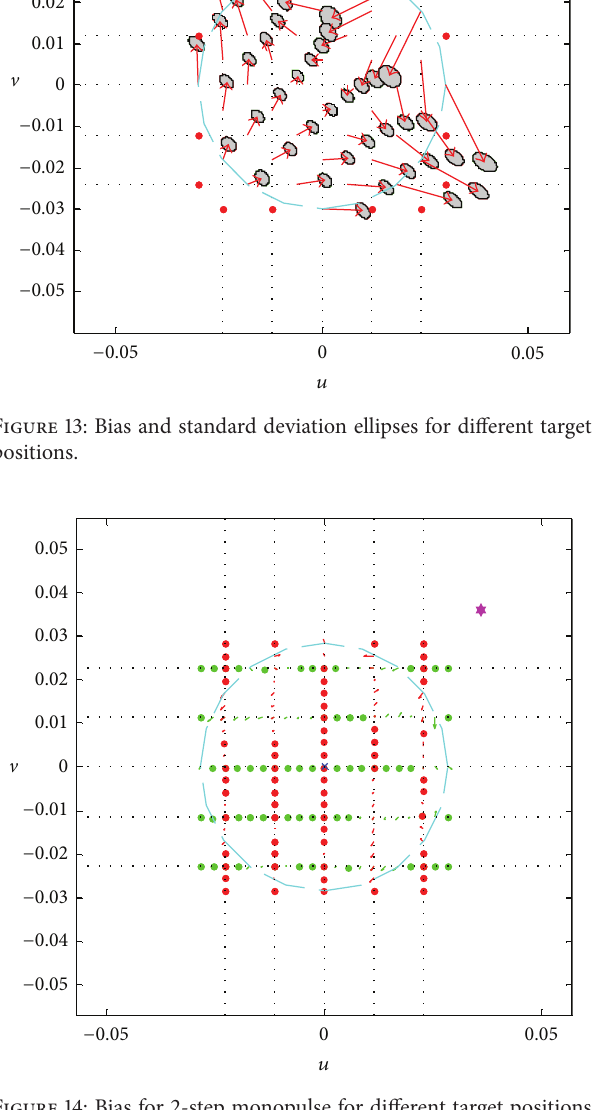
Figure 14: Bias for 2-step monopulse for different target positions and jammer scenario of Figure